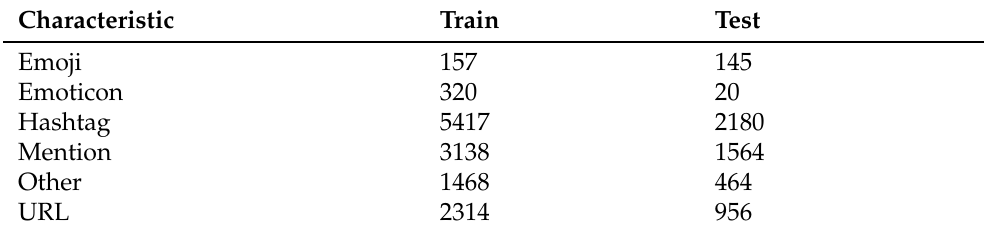
Table 4. SENTIPOLC 2016 dataset